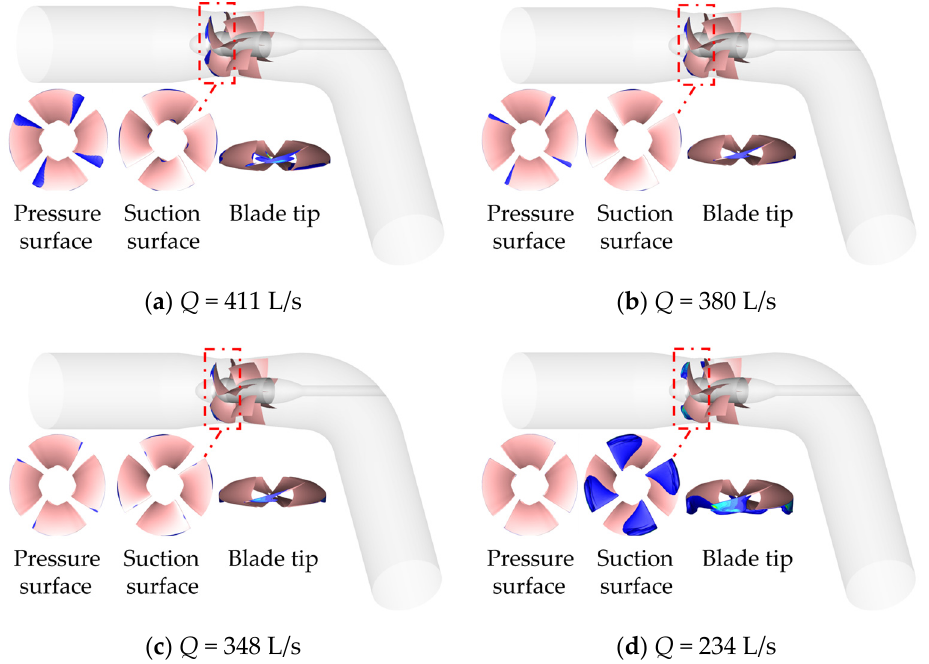
Figure 12. Air bubble distribution volume cloud diagrams at p in = 7 × 10 4 Pa.